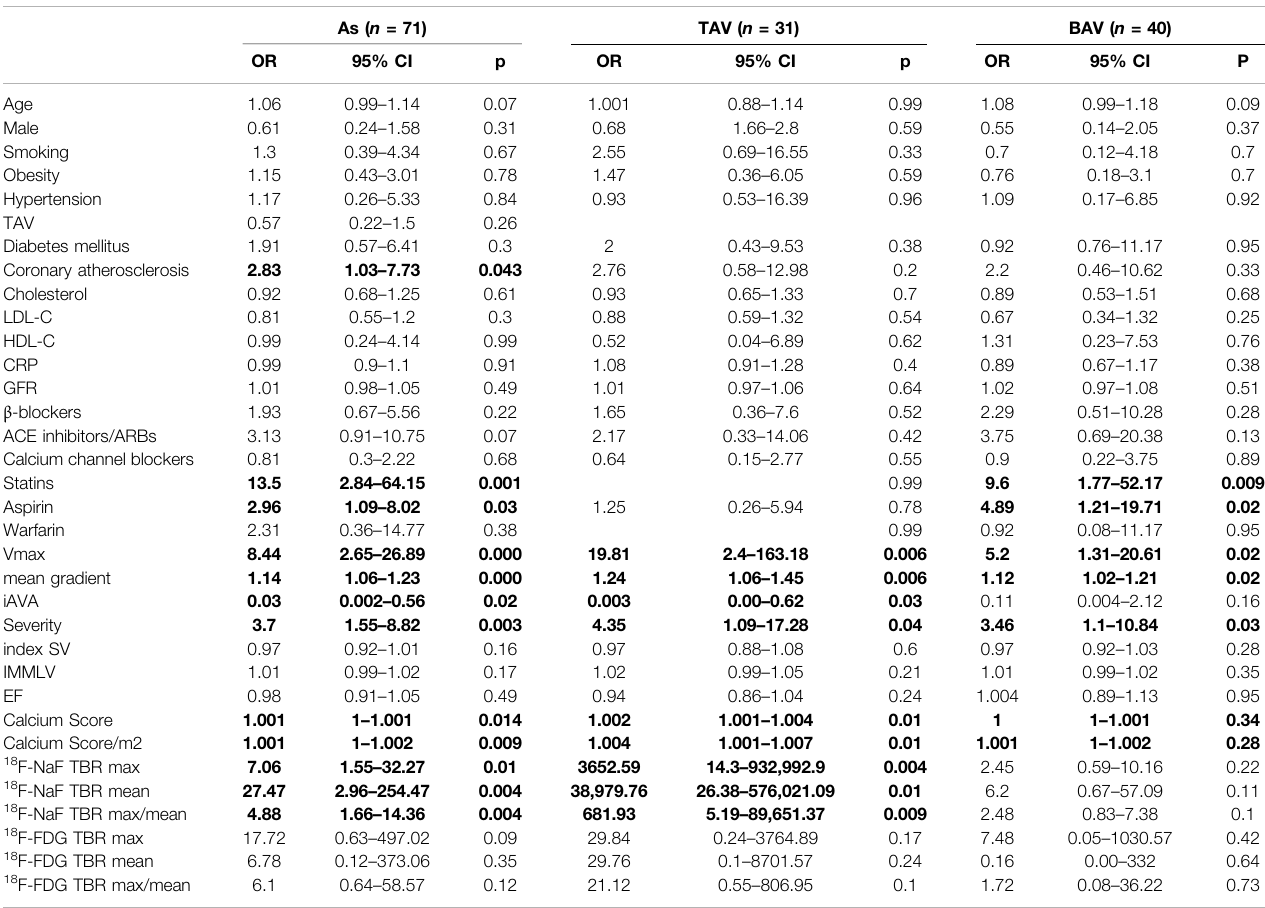
TABLE 2 | Results of univariate binary logistic regression analysis to investigate predictors of AS